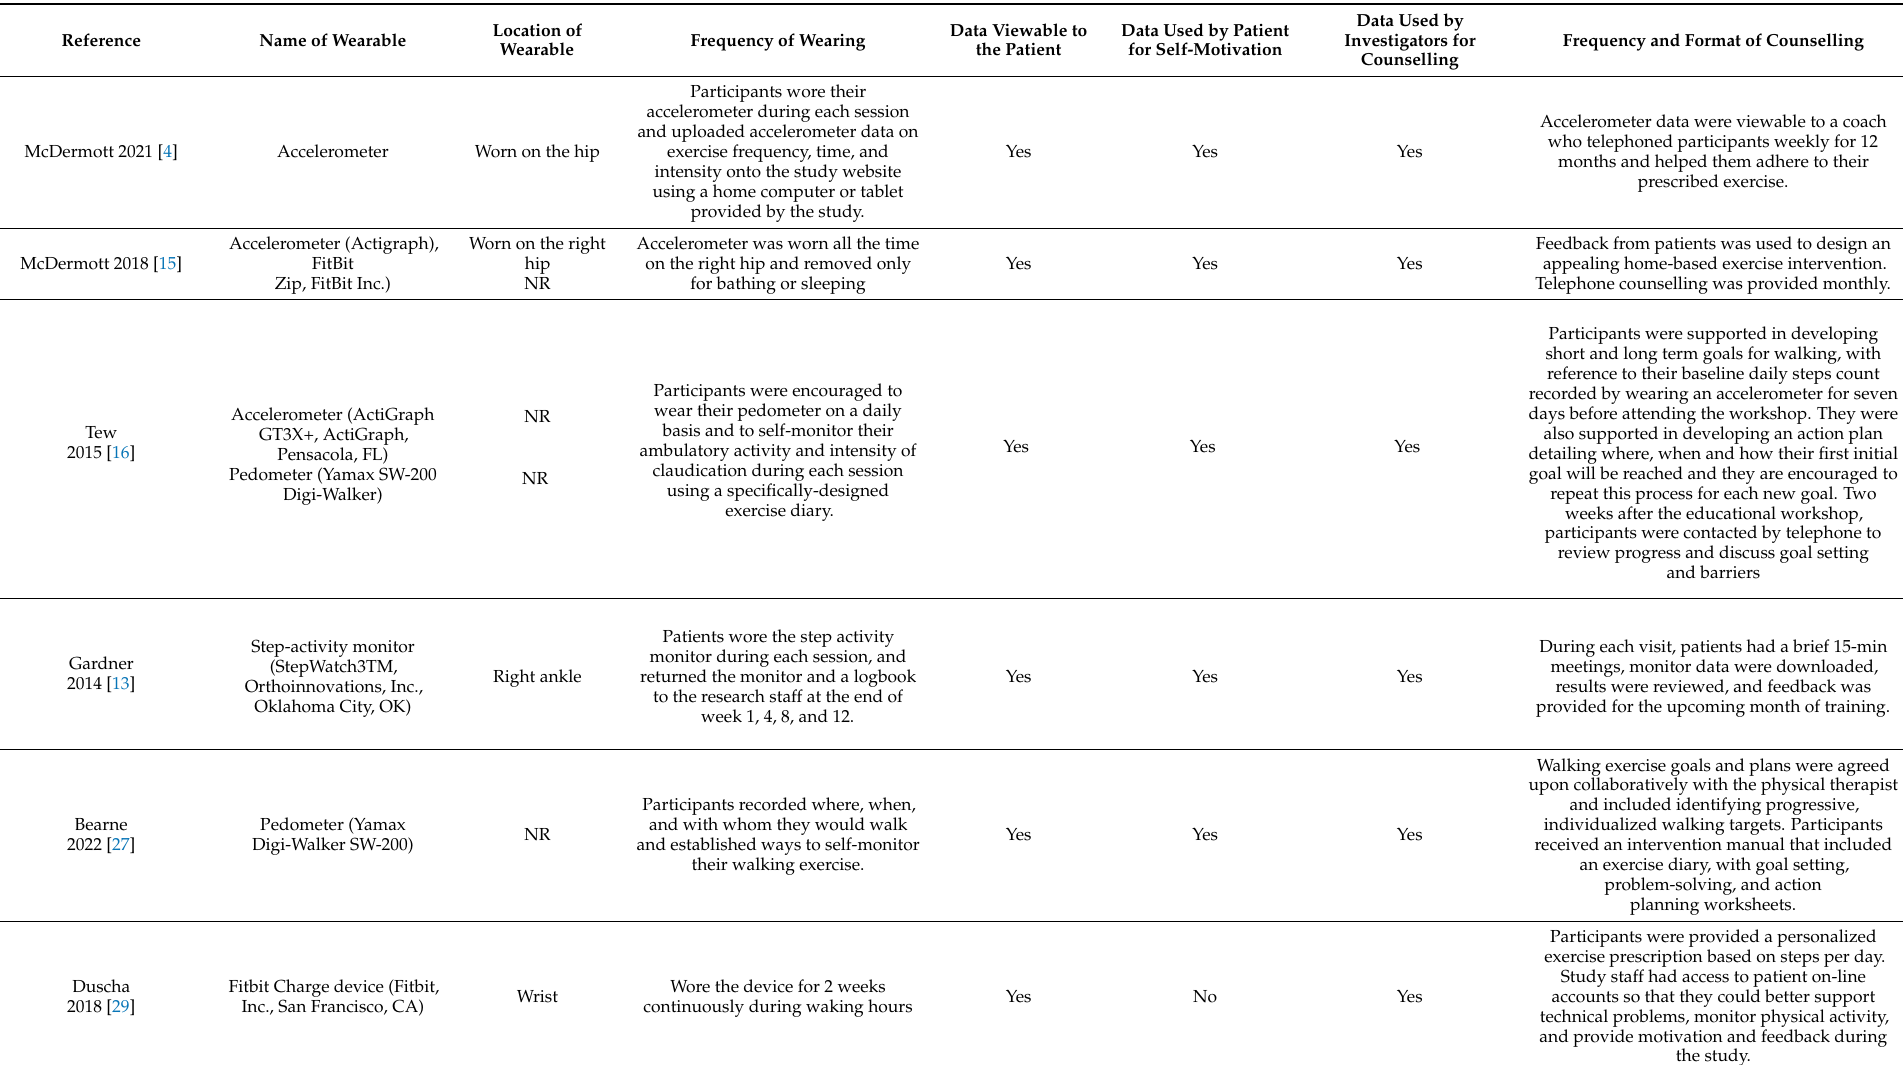
Table 3. Use of the activity data for